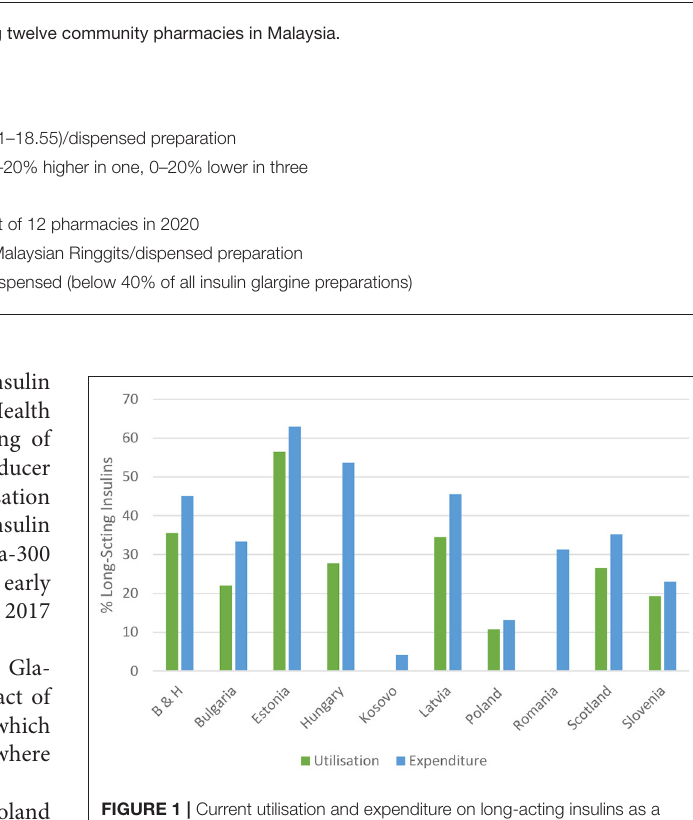
FIGURE 1 | Current utilisation and expenditure on long-acting insulins as a percentage of total insulins among European countries in either 2019 or 2020. NB: B & H, Bosnia and Herzegovina; DDD based with differences in expenditures based on local